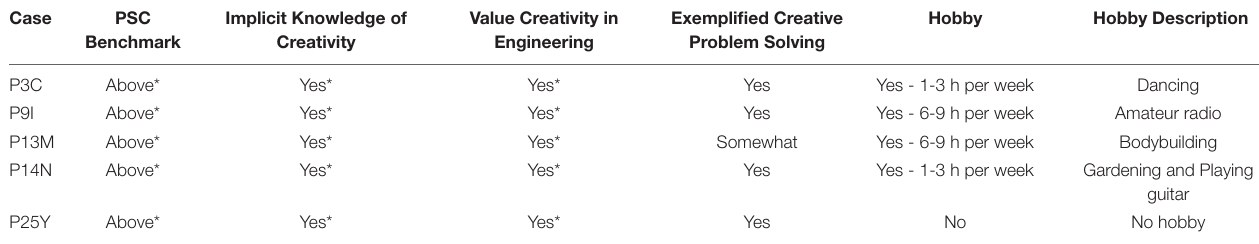
TABLE 8 | Measures and Hobby information by exceptional